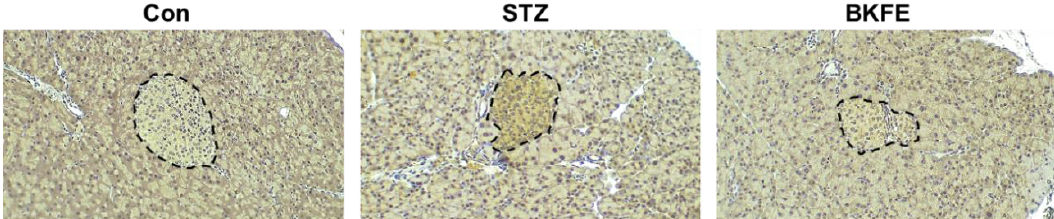
Figure 3. BKFE reduces oxidative stress in pancreatic islets of STZ-induced diabetic mice. Immunohistochemical detection of 4-hydroxynonenal (4HNE) as a marker for oxidative stress was performed in pancreas sections from experimental mice treated with STZ and/or BKFE and non-diabetic controls. 4HNE staining is shown as a brown reaction area demarcated by the black dotted line, and the nuclei are stained with hematoxylin. Representative microscopy images were examined by light microscopy (original magnification, 100×, n = 4). Con, Vehicle-treated nondiabetes; STZ, Vehicle + STZ; BKFE, BKFE + STZ.